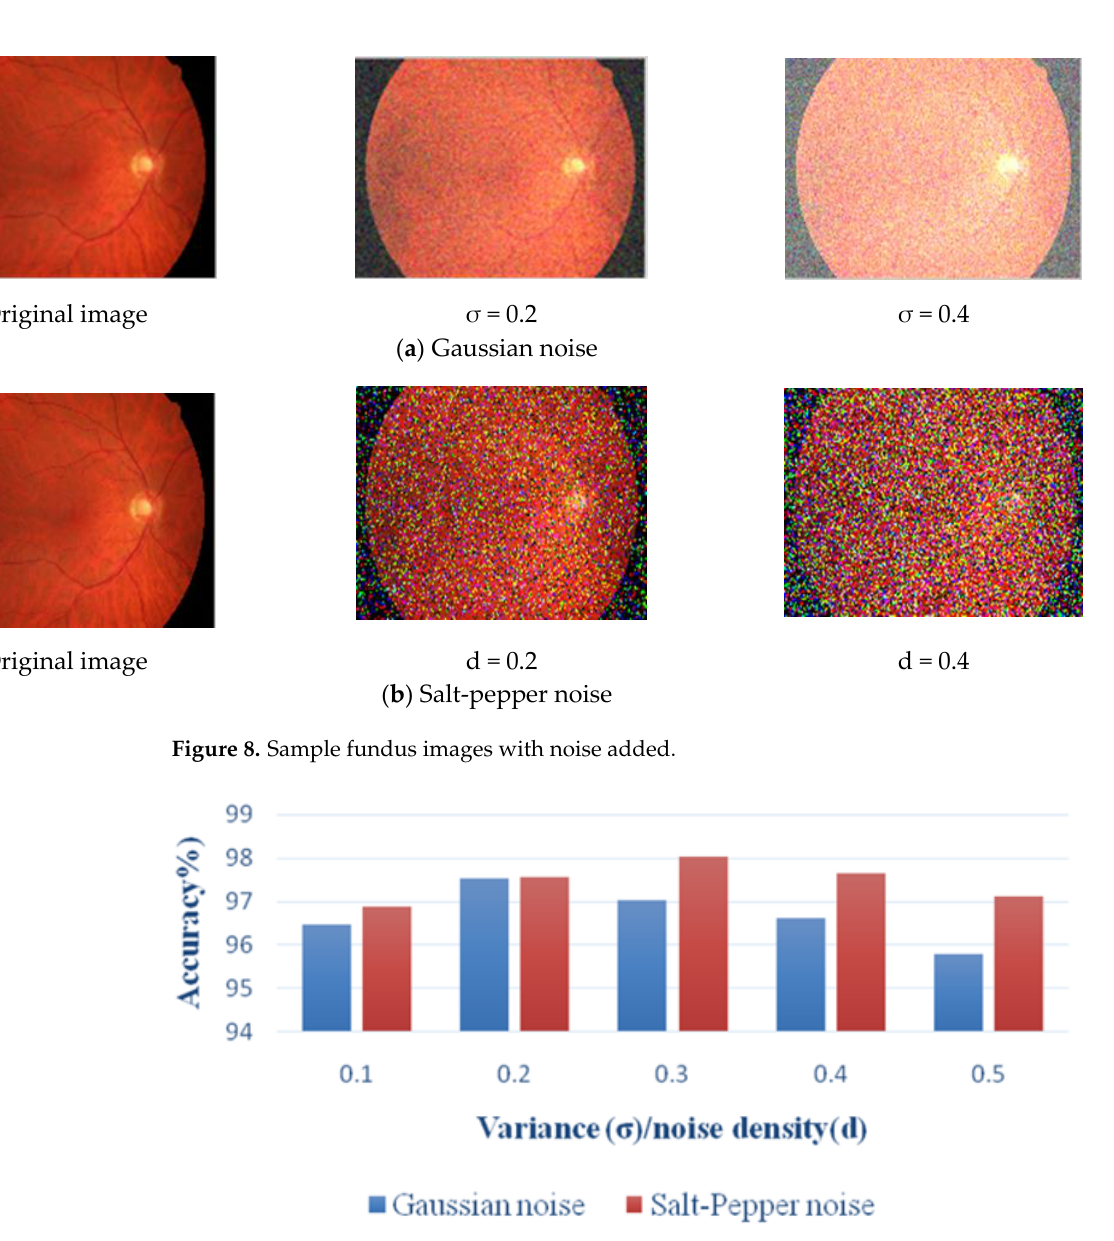
Table 10. Comparison of DBN-EHO with CNN models employing transfer learning.